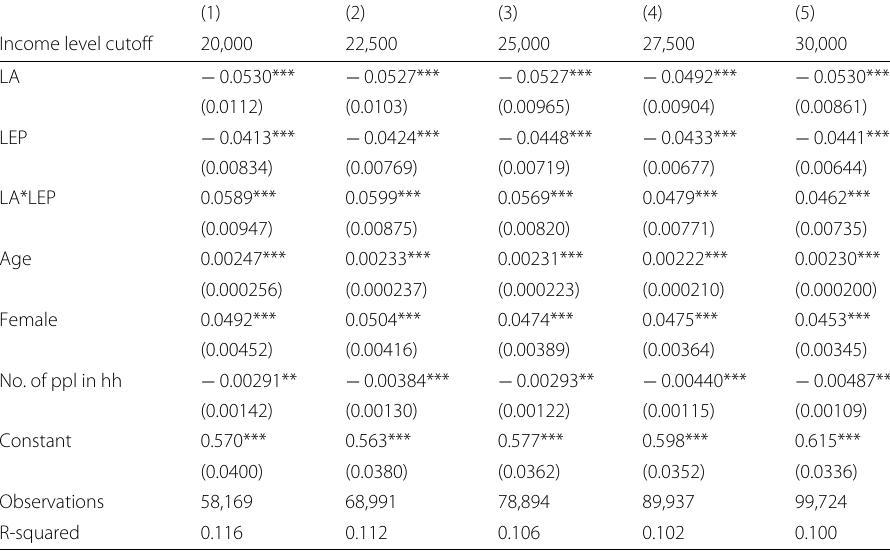
Table 6 Language access, insurance coverage, and crowd-out: any